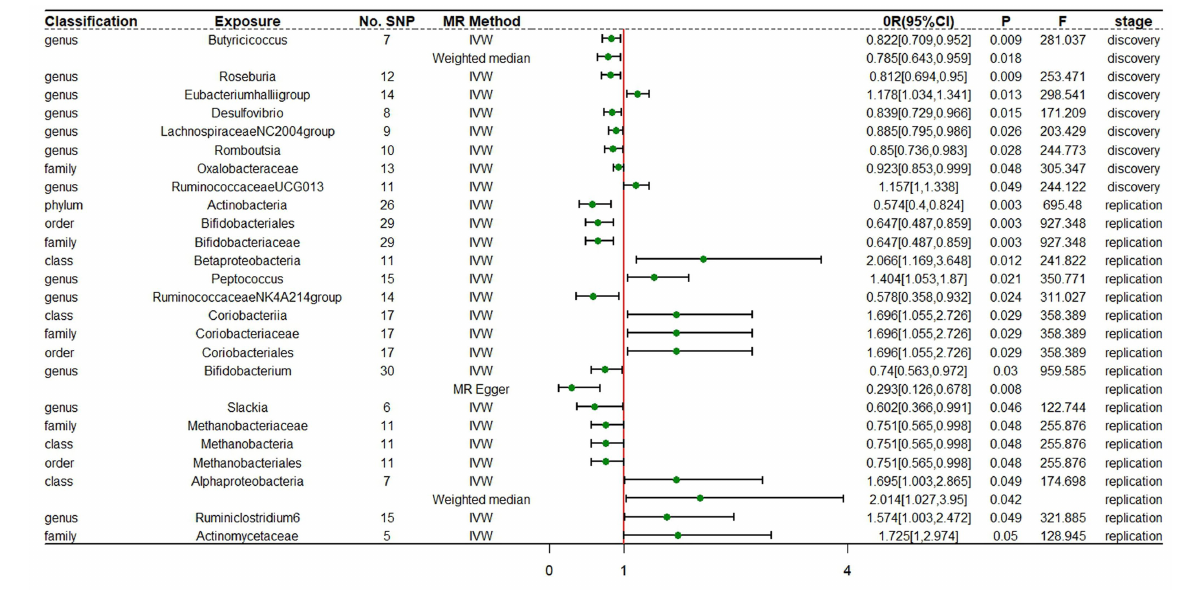
FIGURE 2 Forest plot of MR estimates at locus-wide significance level ( p < 1 × 10 − 5 ). No.SNP, number of SNPs; MR method, the type of model applied in MR analysis; OR, odds ratio; CI, confidence interval; P, p -value of causal estimation in different MR methods; F, F